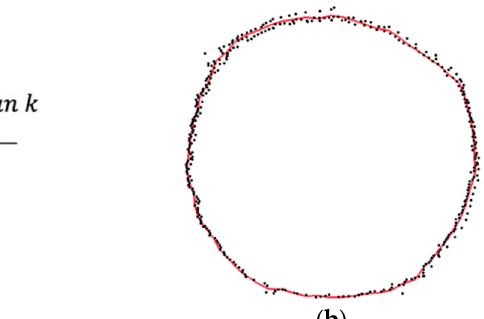
Figure 12. Detailed sectional shape of a stem. ( a ) Median distance in a fan; ( b ) N -sided polygon of a stem sectional